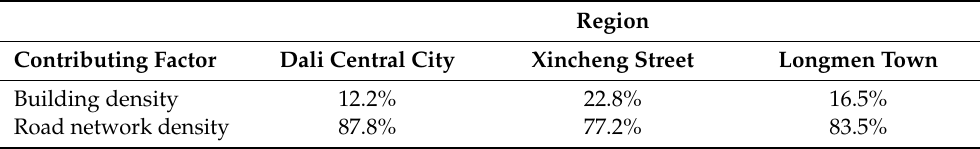
Table 11. Contribution statistics for inefficient commercial